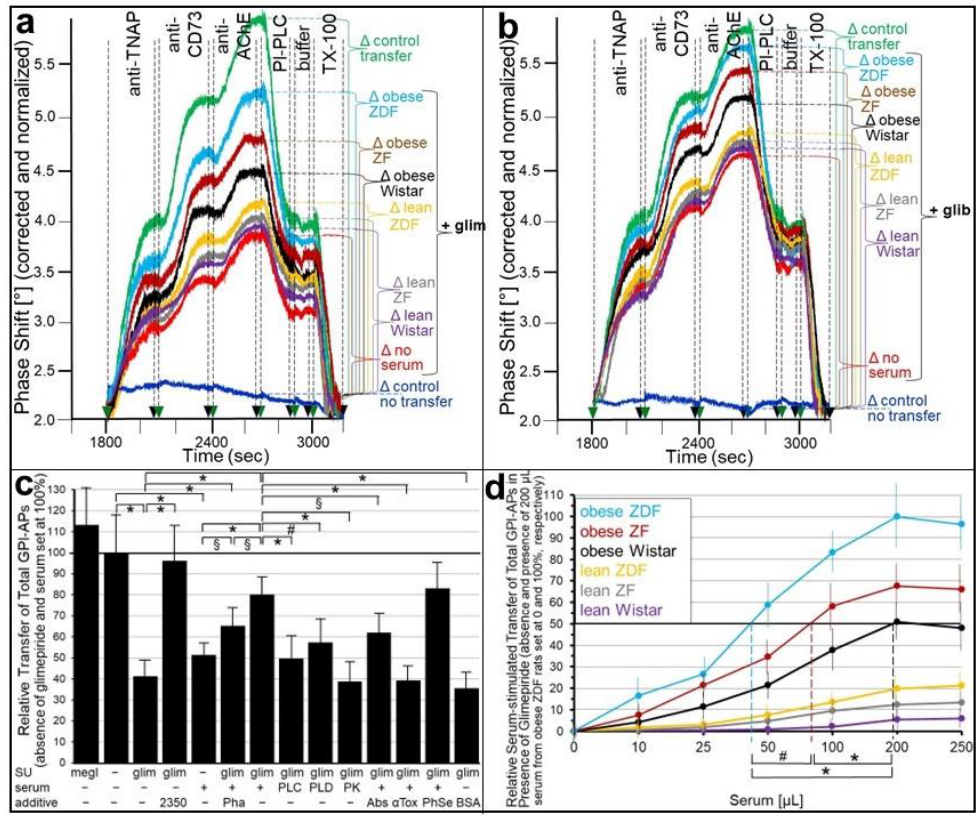
Figure 6. Abrogation of the SU inhibition of GPI-AP transfer by serum. ( a – d ) Transwell co-cultures were run with human donor adipocytes (of lipid-loading stage II) or only medium (shown only for ( a , b ); control no transfer) and GPI-deficient EL acceptor cells in the insert and bottom wells, respec- tively, as described in Section 4. The co-cultures were incubated (1 week, 37 °C, 5 mM glucose) in the absence (( a , b ); control transfer) or presence of 30 µM glimepiride ( a , d ) without or with 100 µM GPI2350 (c; 2350) or 30 µM glibenclamide ( b ) or 50 µM meglitinide (c; megl) in the absence (( a , b ); no serum) or presence of 100 µL ( a – c ) or increasing volumes ( d ) of serum, which had been prepared from lean or obese Wistar, ZF or ZDF rats ( a , b , d ) or obese ZDF rats ( c ) and then diluted 10-fold with PBS containing 2 mM Pha, or of 100 µL of BSA (4 mg/mL PBS) in the presence of 4 mM Ca 2+ ( a – d ) or 1 mM Pha (only ( c )). PMs were prepared from the ELCs of the bottom wells, coupled to chips by ionic/covalent capture and then analyzed for the expression of GPI-APs by SAW sensing, as de- scribed for Figure 1. Phase shifts induced by the binding of antibodies against GPI-APs and subse- quent treatments with PI-PLC and TX-100 (1800 – 3200 s) are shown only, omitting the preceding capturing of PMs (0 – 700 s), as well as the binding of antibodies against TMPs (700 – 1800 s). Serum samples were left untreated ( a , b , d ) or ( c ) digested with bacterial PI-PLC (PLC), human GPLD1 (PLD) or proteinase K (PK) or supplemented with antibodies against TNAP, CD73 and AChE (Abs) or α - toxin (αTox), each coupled to Sepharose beads or phenyl Sepharose beads (PhSe) or Pha (1 mM) prior to addition to the transwell co-cultures. ( a , b ) Correction and normalization of the phase shift were performed, as described for Figure 1. Phase shift Δ between the start of the injection of the anti-TNAP antibody (at 1800 s) and termination of the injection of anti-AChE antibody (at 2700 s) are indicated by horizontal, hatched lines and brackets for each incubation condition. ( c ) The ex- periment was repeated four times (distinct co-cultures with SAW sensing in triplicate). Phase shift Δ induced by antibodies against TNAP, CD73 and AChE (180 0 – 2700 s) were corrected for medium alone in the insert wells and used for the calculation of the relative transfer of total GPI-APs, with the absence of SUs, serum and additives set at 100% (horizontal, black line). Biologically relevant significant differences are indicated. ( d ) The experiment (see ( a )) was repeated three to five times (distinct co-cultures with SAW sensing in duplicate) with increasing volumes of sera from rats of different metabolic states in the presence of 30 μM glimepiride. Phase shift Δ induced by antibodies against TNAP, CD73 and AChE (1800 – 2700 s) were corrected for medium alone in the insert wells and used for the calculation of the relative serum-stimulated transfer of total GPI-APs in the pres- ence of glimepiride with the absence and presence of 200 µL serum from obese ZDF rats set at 0 and